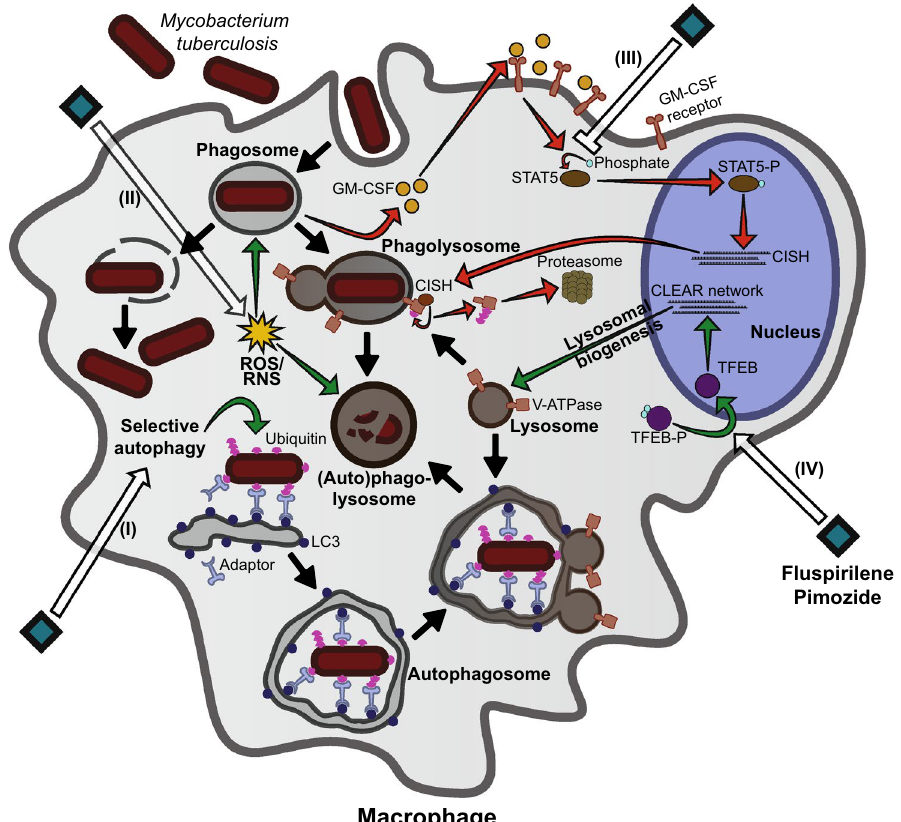
Figure 6. Model of the modes of action of Fluspirilene and Pimozide. Both Fluspirilene and Pimozide increased the localization of Mtb in autophagy-related vesicles implying they induce selective autophagy, i.e. xenophagy (I). Although increased ROS/RNS production was significantly induced by Pimozide only, antioxidants impaired the efficacy of Pimozide and to a lesser extent also Fluspirilene (II). Fluspirilene and Pimozide both inhibited STAT5 activity and Pimozide consequently reduced CISH localization on the Mtb containing vesicle (III). Lastly, Fluspirilene and to a larger extent Pimozide, increased nuclear TFEB localization concomitant with an increased lysosomal response (IV). Black arrows indicate the general process of Mtb phagocytosis and subsequent events, white arrows show compound mediated activation or inhibition of targets and green and red lines depict signaling pathways and protein interactions with reduced or increased bacterial outgrowth as outcome,